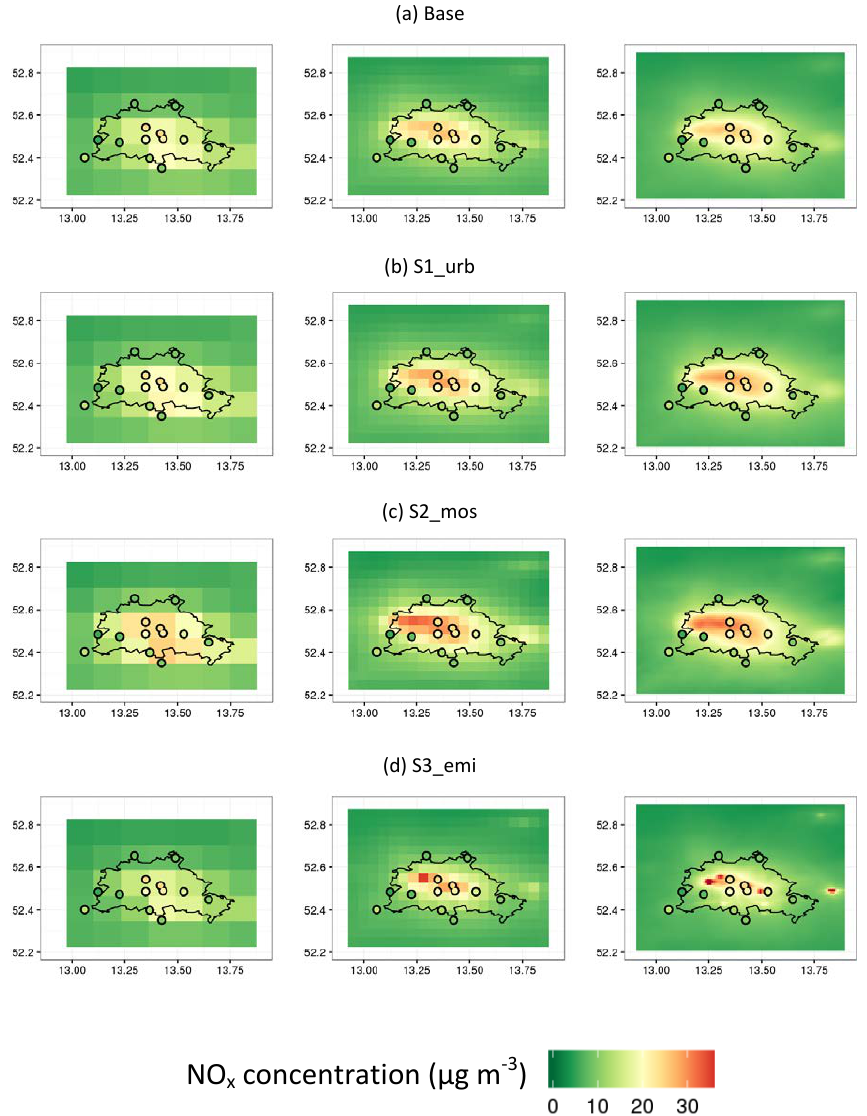
Figure 10. JJA mean modelled (coloured fields) and observed (coloured circles) NO x concentration in Berlin and its surroundings from middle shows results from a 3km horizontal resolution and the right column shows results from a 1km horizontal